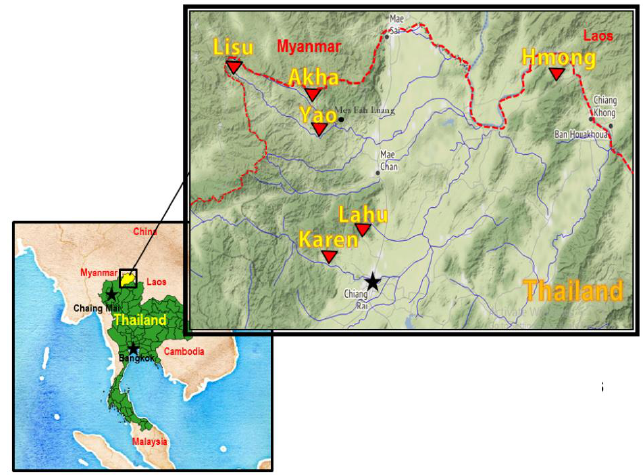
Figure 1. Study sites of six hill tribes in Chiang Rai province, Thailand.